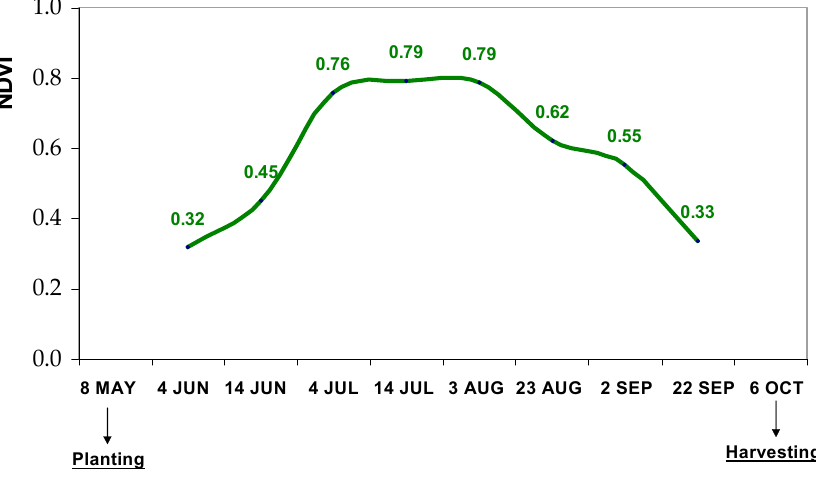
Figure 8. Evolution of mean normalized difference vegetation index (NDVI) between June and September 2017.